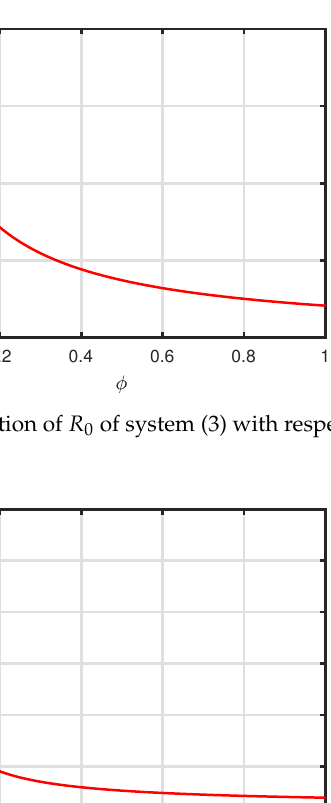
Figure 8. Variation of R 0 of system (3) with respect to β 2 while values of other parameters are taken from Table 3.